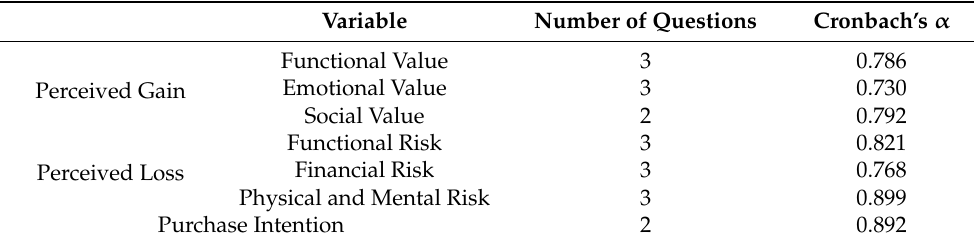
Table 5. Reliability analysis results of electric vehicle purchase intention.